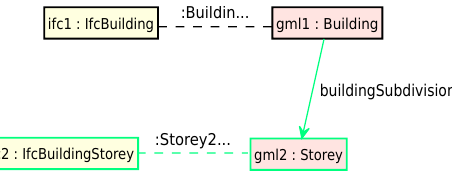
Figure 4. Abstract rule for storeys metamodels elements (e.g. type and attribute names).